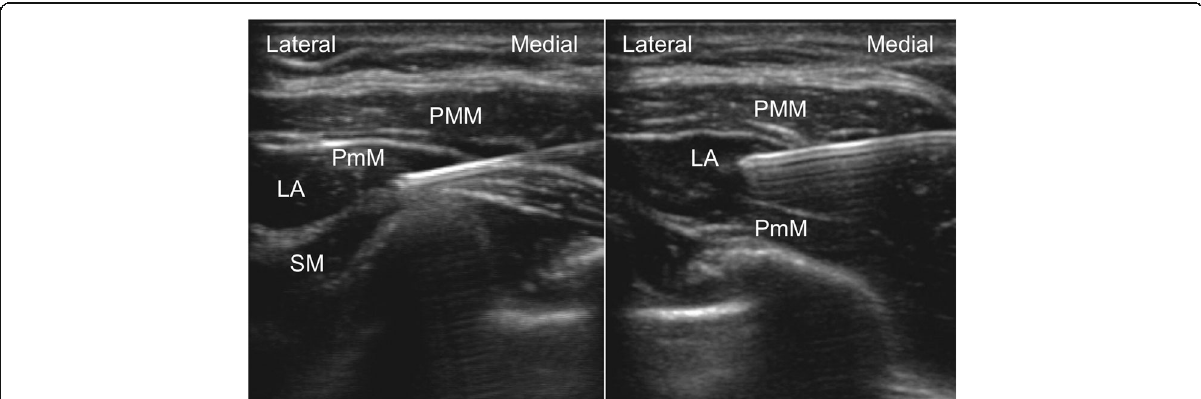
Fig. 1 Ultrasound images of pectoral nerve II block. The left image shows injection of local anesthetics between the pectoralis minor muscle and the serratus anterior muscle. The right image shows injection of local anesthetics between the pectoralis major muscle and the pectoralis minor muscle. LA, local anesthetics; PmM, pectoralis minor muscle; PMM, pectoralis major muscle; SM, serratus anterior